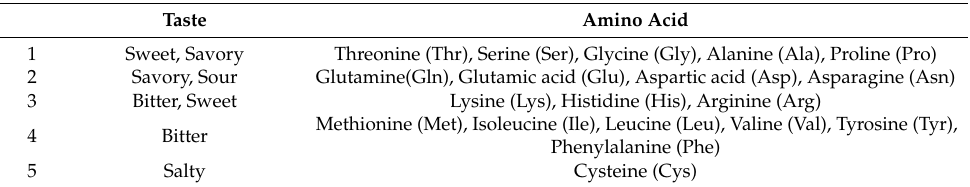
Table 3. The group of amino acids of different